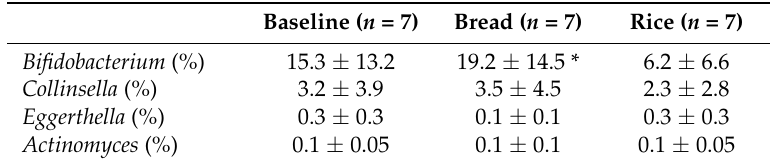
Table 3. Mean value of genera of the Actinobacteria phylum identified in fecal samples at baseline, and after bread and rice